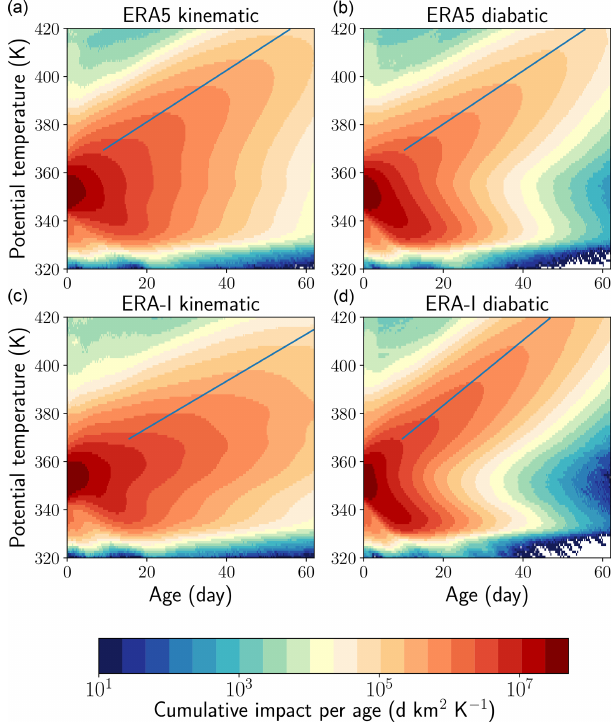
Figure 5. Distribution of the cumulated impact as a function of alti- tude and age with respect to the launch of the convective parcels. (a, b) ERA5. (c, d) ERA-Interim. (a, c) Kinematic trajectories. (b, d) Diabatic trajectories. The slopes follow the crests of the dis- tribution at each level (see also Sect. S4 of the